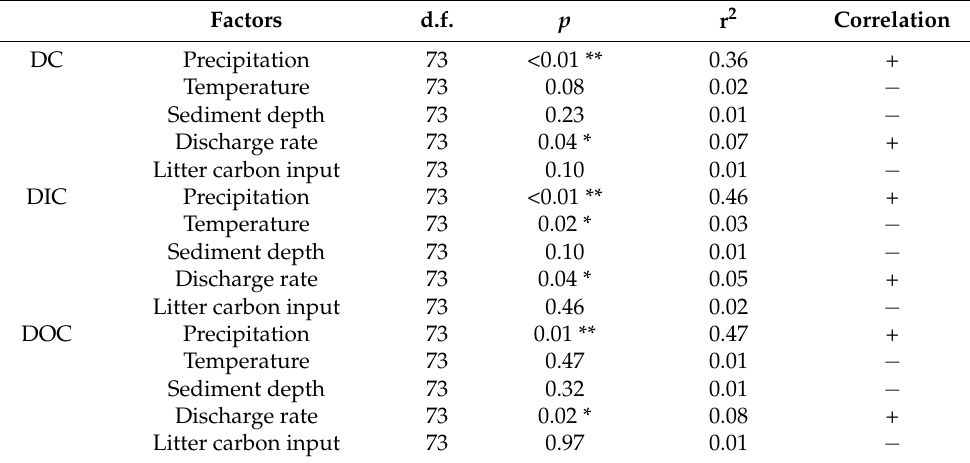
Table 2. Relationships between dissolved carbon (DC), dissolved inorganic carbon (DIC), and dissolved organic carbon (DOC) stocks and investigated stream characteristics in the subalpine forest